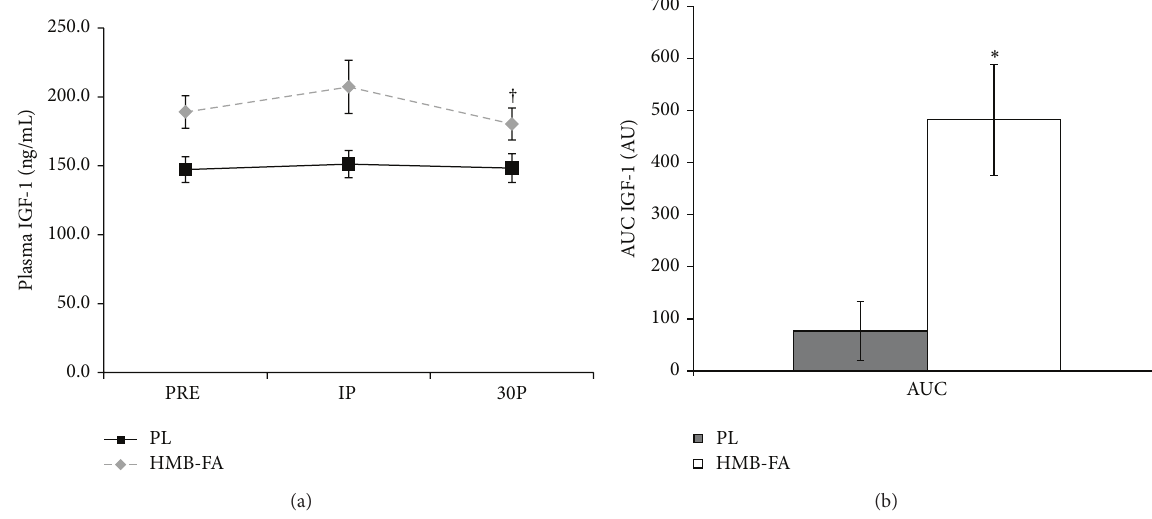
Figure 5: (a) Plasma insulin-like growth factor (IGF-1) concentration values for placebo (PL) and 𝛽 -hydroxy- 𝛽 -methylbutyrate free acid (HMB-FA) groups before exercise (PRE), immediately after exercise (IP), and 30 minutes after exercise (30P). † Both groups significantly lower than PRE values. (b) Area under the curve (AUC) analysis for plasma IGF-1 levels for PL and HMB-FA groups. Data were reported as mean ± SD. ∗ Indicating HMB-FA group significantly greater than